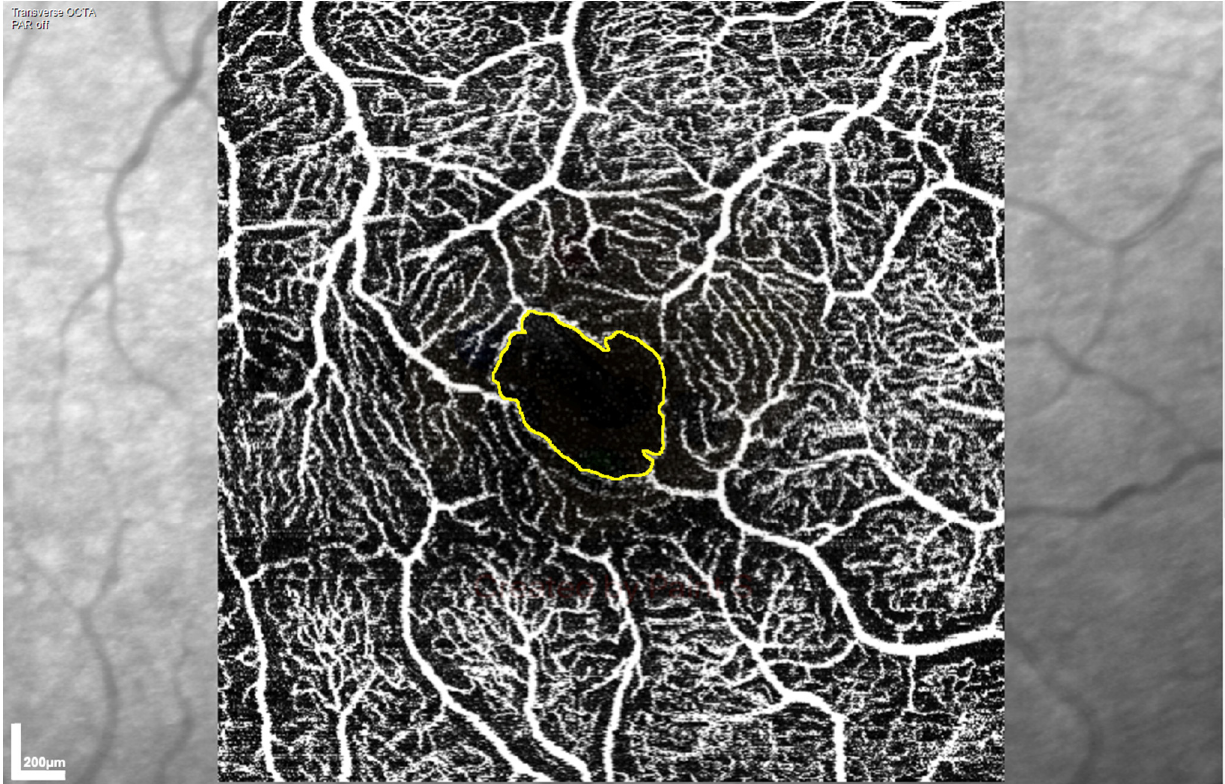
Figure 1. Representative low-power image of the foveal avascular zone (FAZ) area at the superficial vascular plexus, acquired by optical coherence tomography angiography (OCTA) and used to assess retinal perfusion. The FAZ is visible as the dark area in the centre of the scan with the drawn yellow outline.